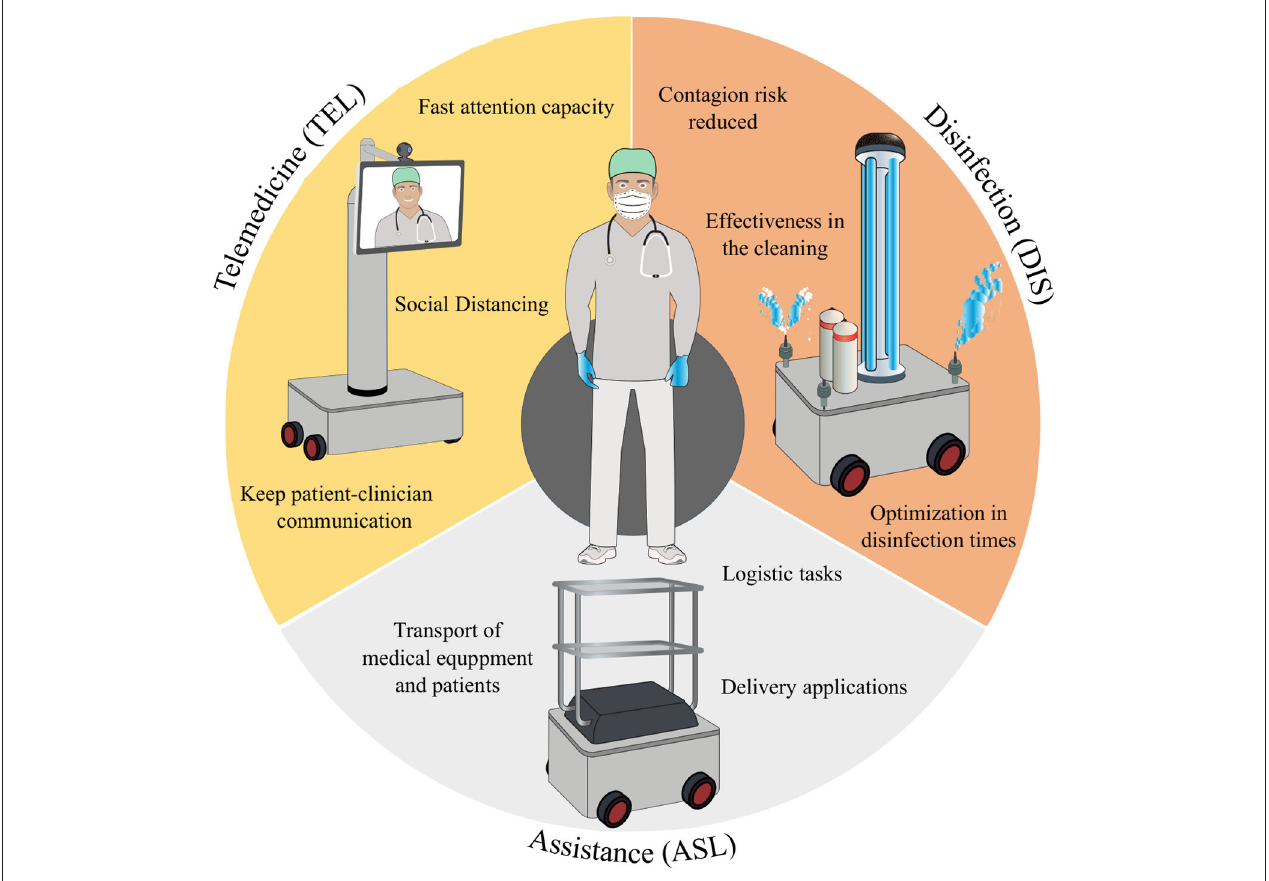
FIGURE 1 | Categories of robotics application considered in this study: (1) Telemedicine (TEL), Disinfection (DIS), and Assistance (ASL). The exhibited characteristics refer to the main advantages of using robots of the corresponding category (i.e., the yellow section for TEL, orange for DIS, and gray for ASL) in clinic